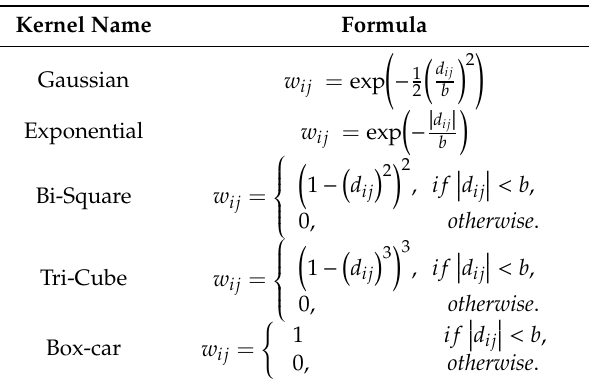
Table 2. Distance weighting kernels implemented in the GWmodel R package where w ij is the j -th element of the diagonal of the weight matrix W used to estimate the local regression at location i , d ij is the distance between the i -th and j -th observations, and b is the